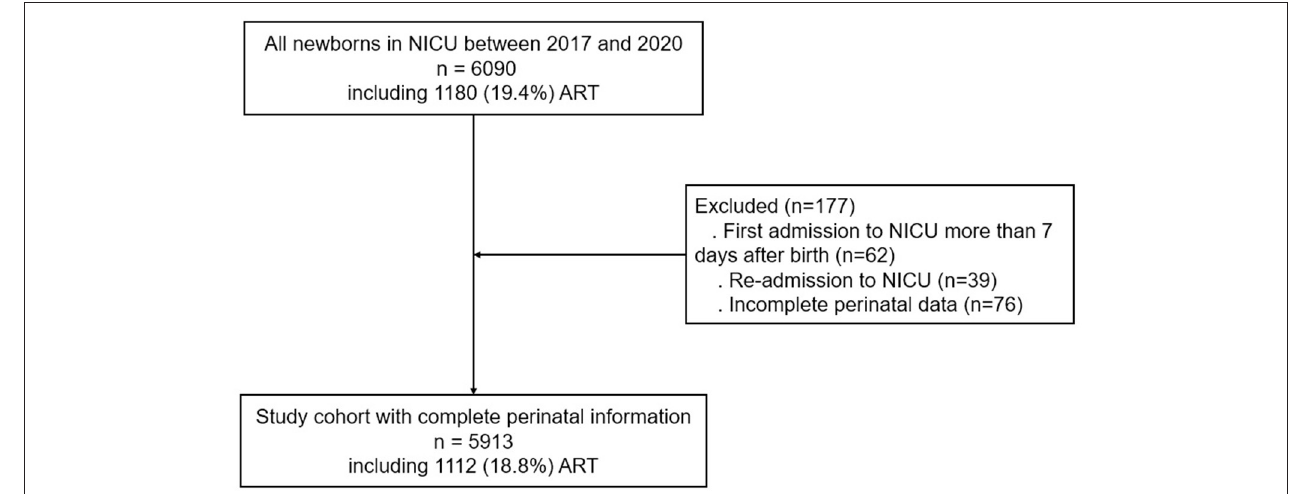
FIGURE 1 | Clinical pathway map of research object selection.